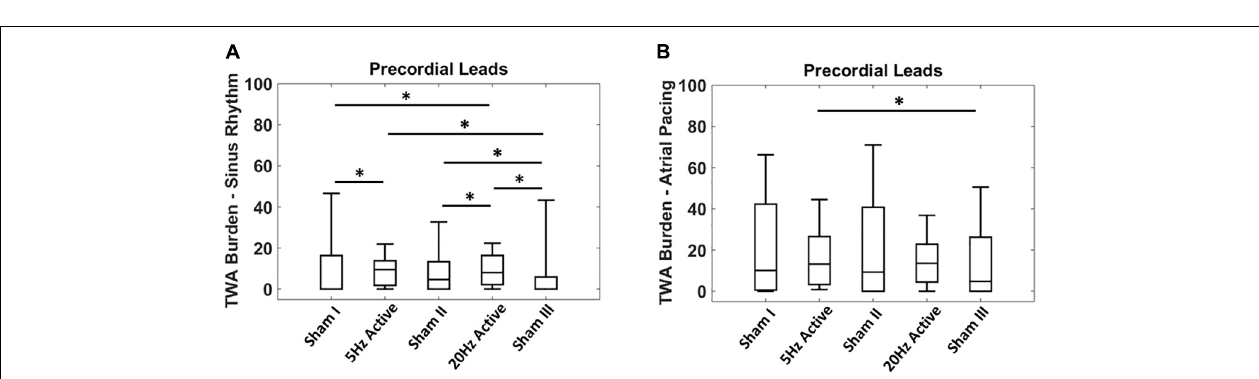
FIGURE 2 | Heart rate dependent effects of tragus stimulation on T-wave alternans (TWA). Quantification of the TWA burden during sinus rhythm and atrial pacing (100 bpm), with sham and active LLTS. TWA burden is significantly elevated in the precordial leads irrespective of LLTS during atrial pacing, compared to sinus rhythm. “*” denotes statistical significance of p < 0.05 using Kruskal-Wallis test.